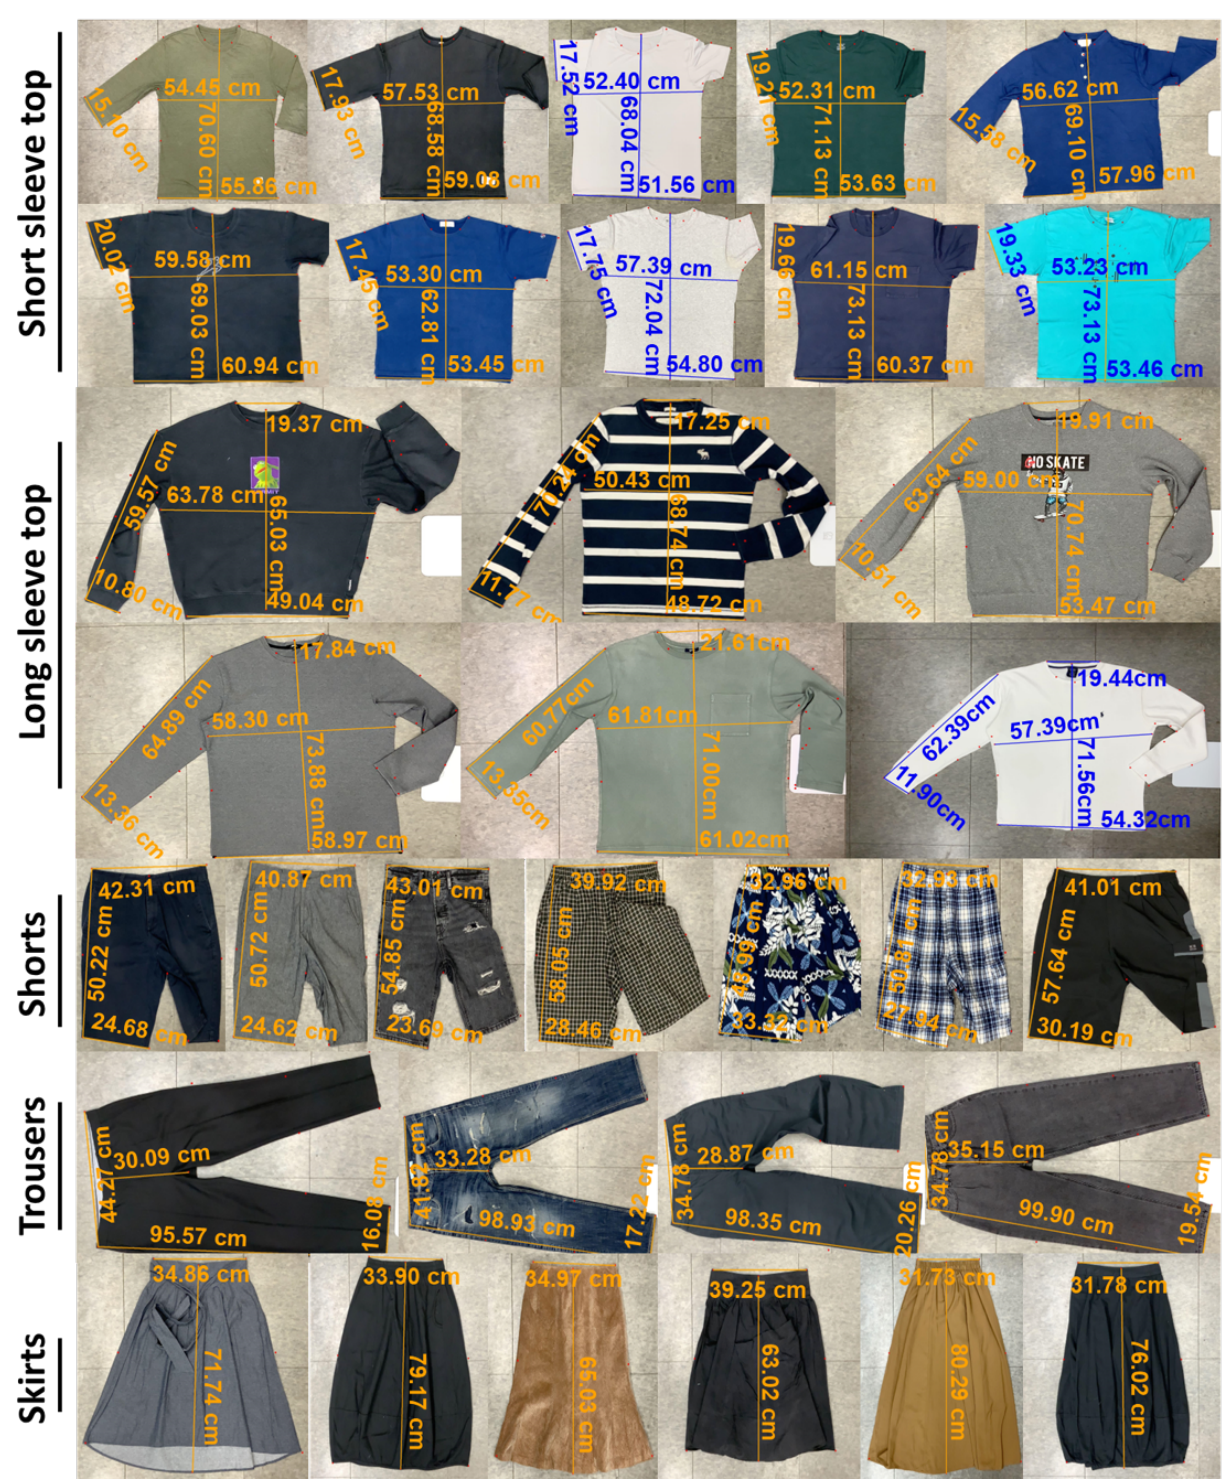
Figure A3. Samples of Experiment 2 (without background) results with 33 pieces of